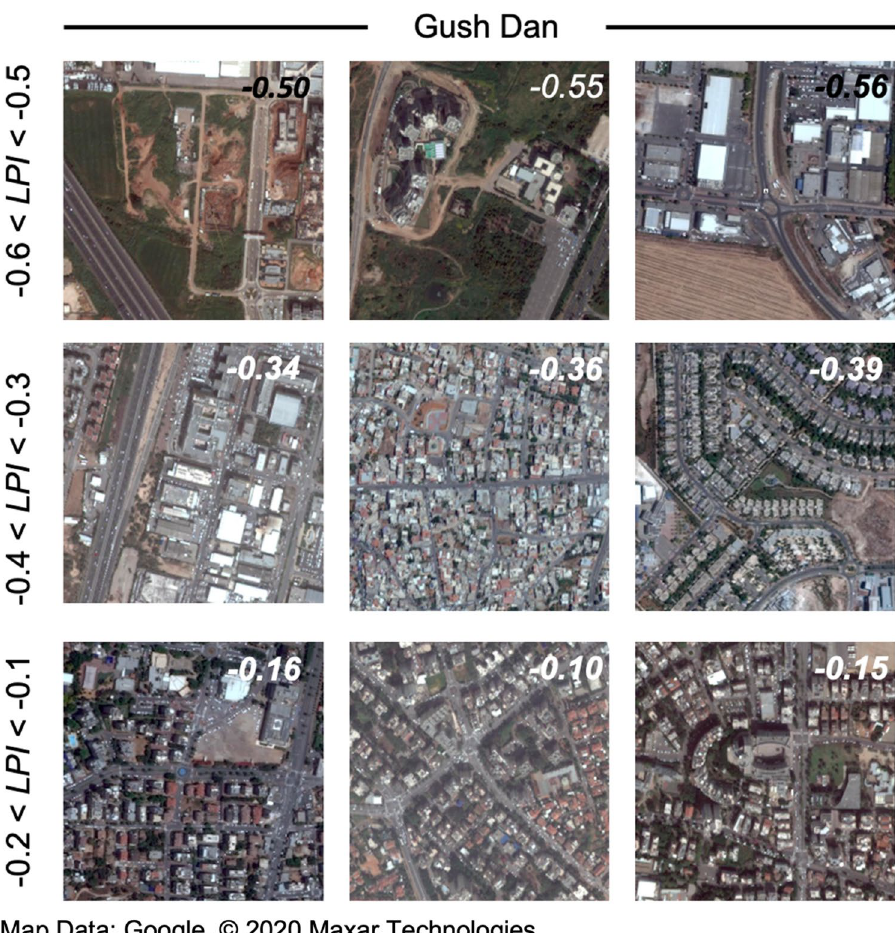
figure see “Methods” section, subsection “Satellite